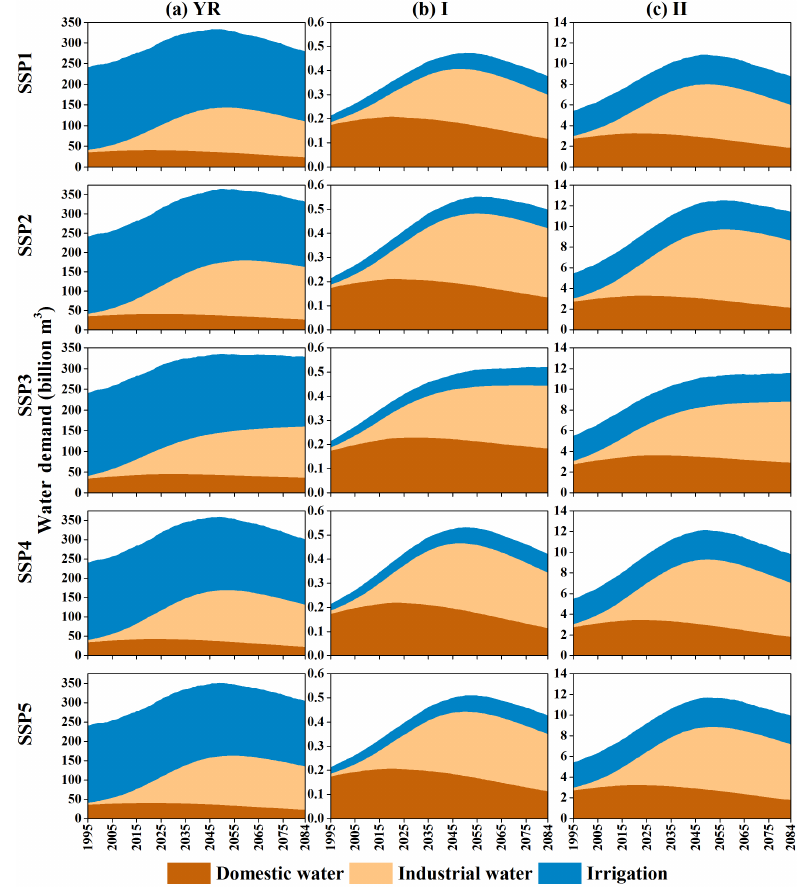
Figure 4. Estimated sectoral (domestic, industrial, and irrigation) and total annual water demand (millionm 3 yr − 1 ) in the YR basin, and sub-basin I and II during the 21st